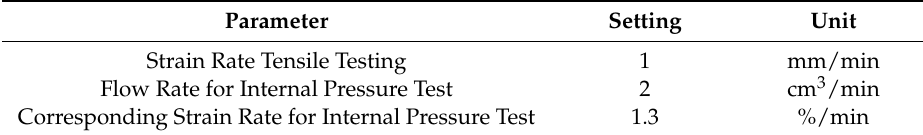
Table 11. Applied parameters of the tensile tests and the internal pressure test.